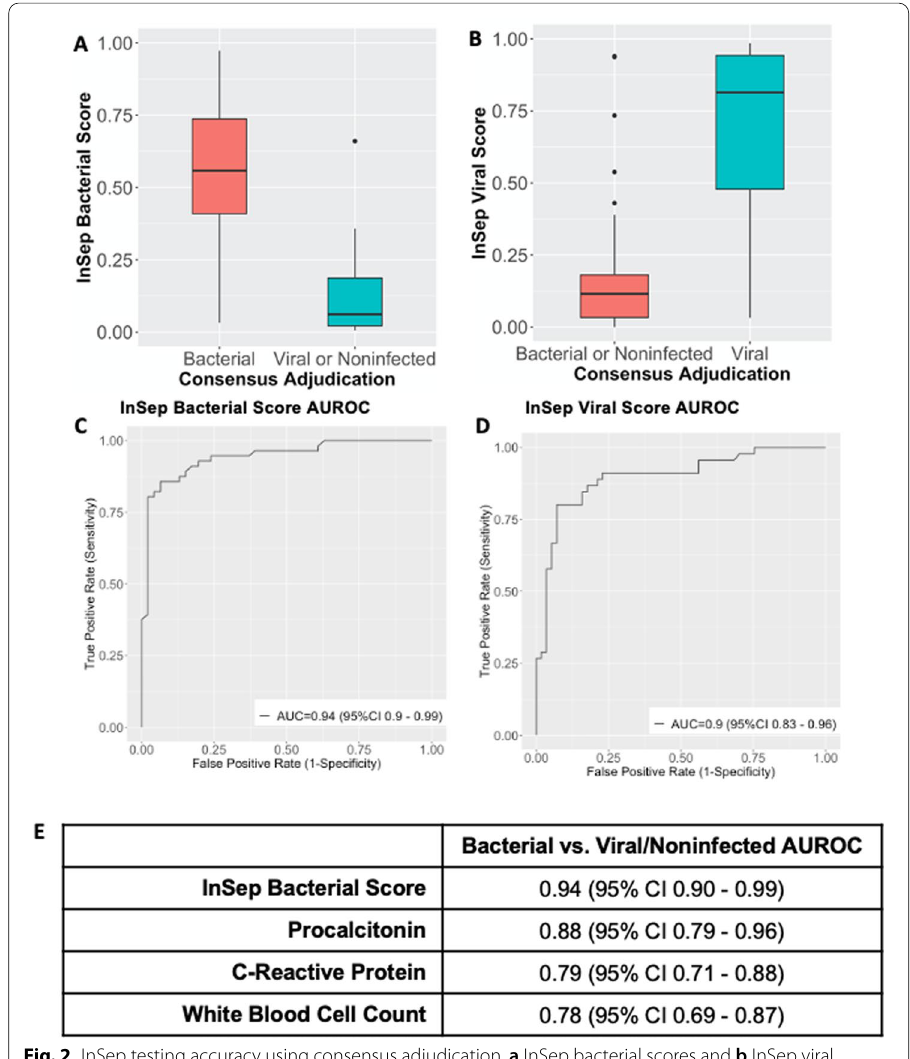
Fig. 2 InSep testing accuracy using consensus adjudication. a InSep bacterial scores and b InSep viral scores among patients with known bacterial, viral, and non‑infected status as determined by three‑physician consensus adjudication. c Area under the receiver operating curves (AUROCs) for InSep bacterial scores (bacterial vs. viral/noninfected predictions). d Area under the receiver operating curves (AUROCs) for InSep viral scores (viral vs. bacterial/noninfected predictions). (E) Bacterial vs. viral/noninfected AUROCs for InSep bacterial scores, procalcitonin, C‑reactive protein, and white blood cell